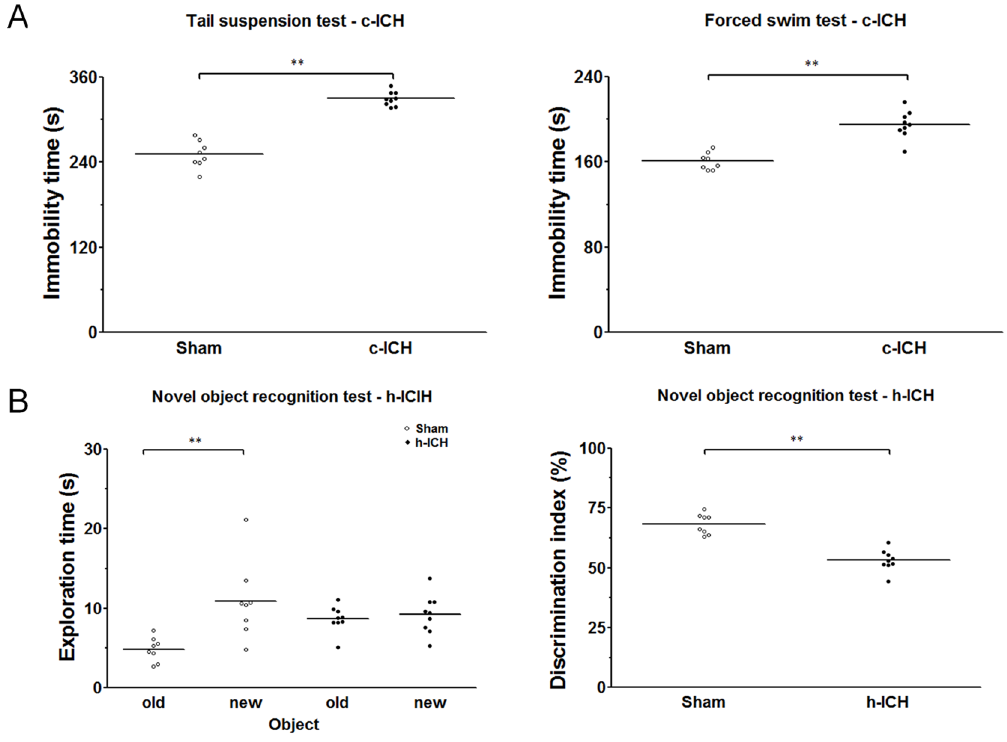
Figure 8. Changes in emotion and memory function after intracerebral hemorrhage (ICH) in cortex and hippocampus. (A) The immobility times in the tail suspension test and in the forced swim test were longer for mice subjected to cortical ICH than for sham-operated control mice (n=9, p , 0.01). (B) In the novel object recognition test, sham-operated mice spent more time exploring the novel object than the old object (n=9 mice per group, p , 0.01), but mice subjected to h-ICH spent a similar amount of time exploring the new and old objects (n=9 mice per group, p . 0.05). Additionally, the discrimination index in the h-ICH group was significantly smaller than that in the sham group (n=9 mice per group, p , 0.01). Values are means 6 SD; ** p , 0.01,